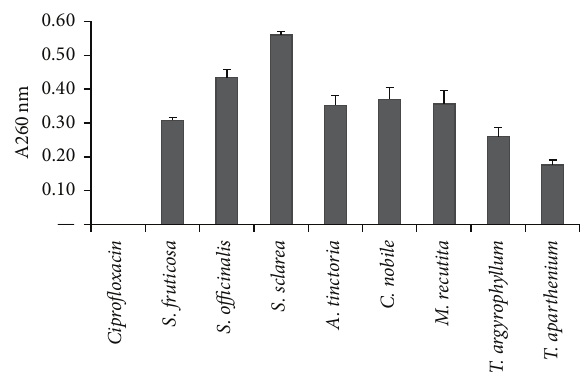
Figure 1: The appearance of 260nm-absorbing material in the filtrates of S. epidermidis Sep6 after 60min treatment with plant extracts in concentration of 5%. Ciprofloxacin was used as control. The means ± SD for at least three replicates are illustrated.